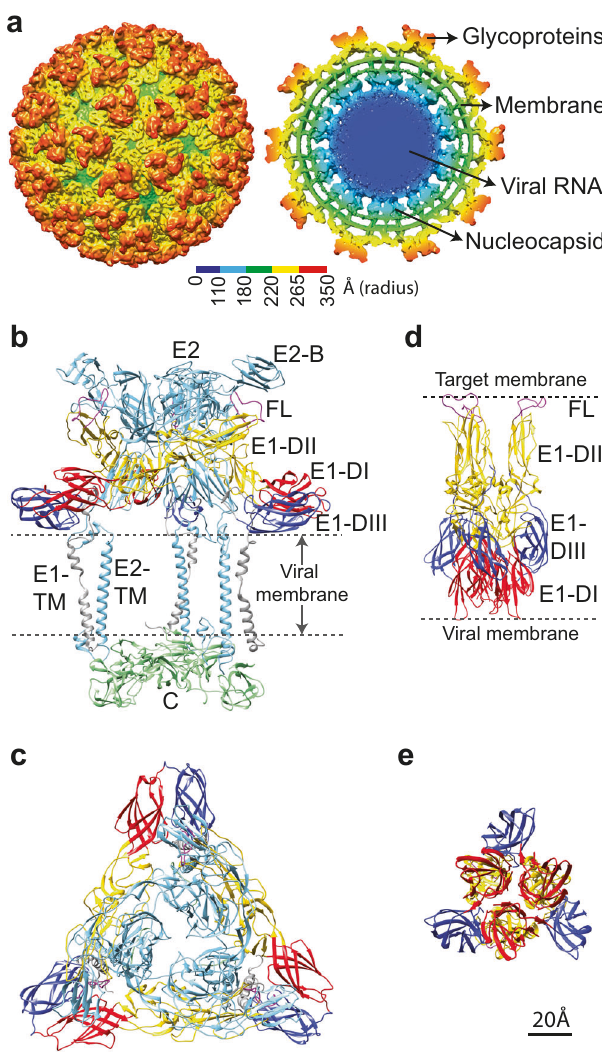
Fig. 1 | Structure of CHIKV particle. a Surface view (left) and cross-sectional view (right) of UV-inactivated CHIKV strain S27. Cryo-EM density map is colored according to radius. b Side view of ribbon structure of the trimeric surface glyco- protein heterodimers in contact with the inner capsid protein as observed in the wild-type virion (PDB ID: 3J2W). c Top view of the trimeric E1-E2 heterodimers on wild-type CHIKV. d , e Side and top view of the crystallographic structure of post- fusion E1 homotrimers (PDB ID: 1RER) respectively. In all panels, E1 is colored according to domains (domain I: red, domain II: yellow, domain III: blue, FL: magenta, E1-transmembrane domain: gray), E2 is in light blue and capsid protein in